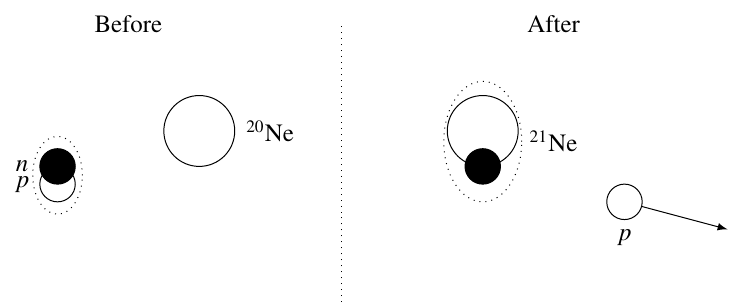
Figure 1. A schematic diagram showing a transfer reaction, in this case 20 Ne( d , p ) 21 Ne. The deuteron projectile is shown as a neutron (black filled circle) and a proton (small hollow circle) bound together, and the 20 Ne target is shown as a large hollow